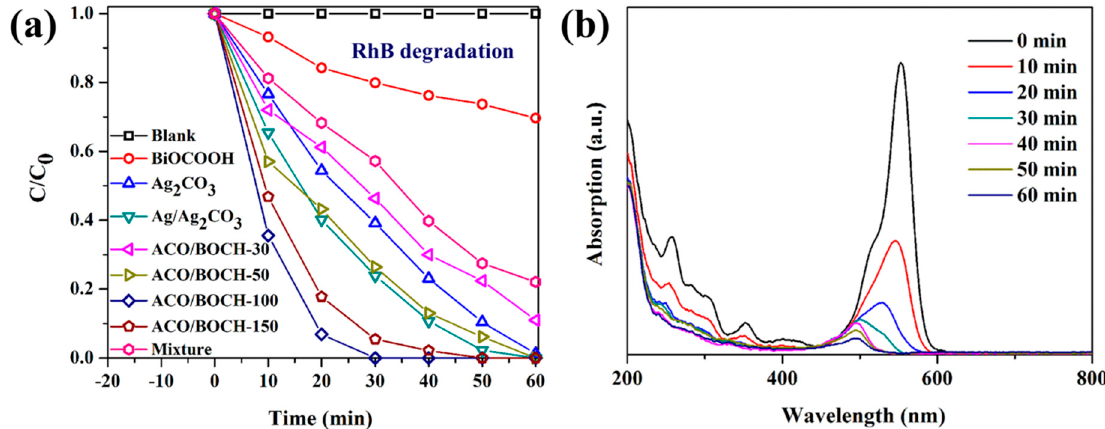
Figure 5. ( a ) Photocatalytic degradation of RhB dye with various catalysts under simulated sunlight. ( b ) Absorption spectra of RhB with irradiation time in the presence of ACO/BOCH-100.